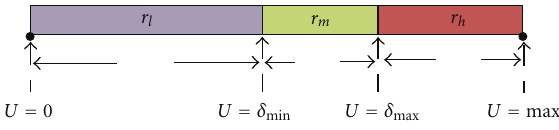
Figure 5: Channel utilization ranges defined on the basis of and δ υ . When υ c ∈ r m , the nodes are moderately thresholds, δ υ min max congested, whereas when υ c ∈ r h , the nodes are completely